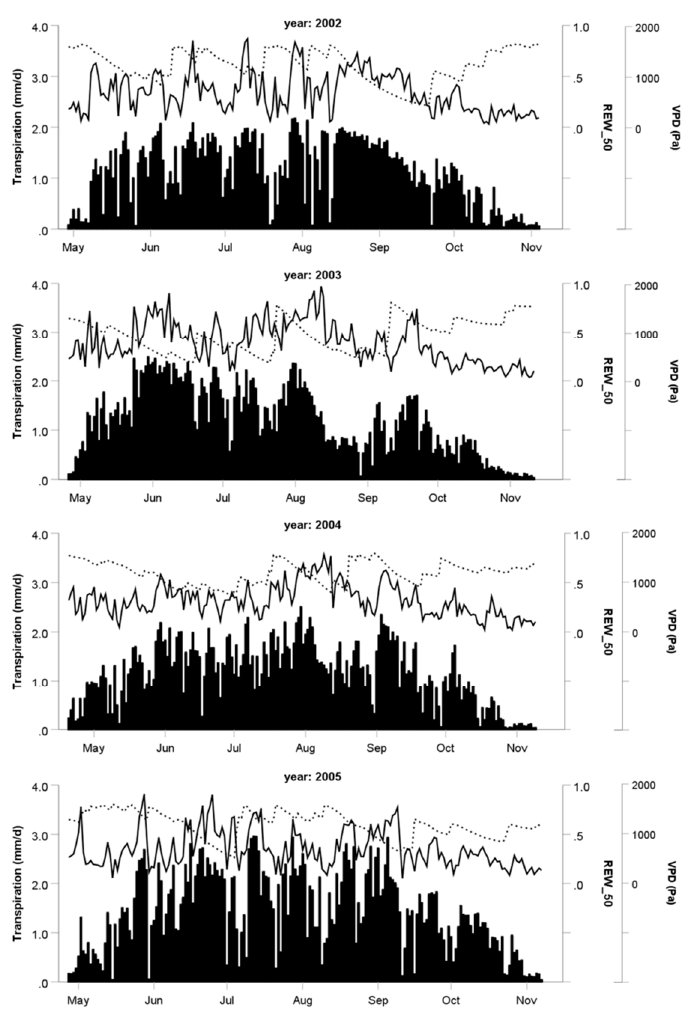
Figure 1. Daily canopy transpiration (bars), VPD (solid lines), and REW 50 (dotted lines) over four seasons (2002–2005).